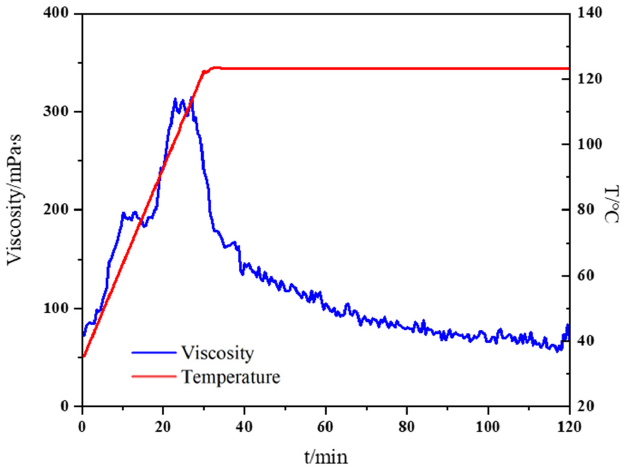
Figure 10. High temperature rheological properties of fracturing fluid.